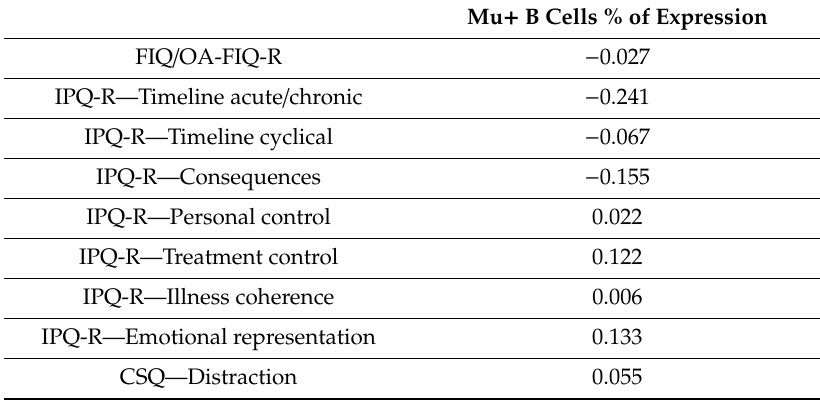
Table 3. Mu + B cells percentage of expression had no significant correlations with any psychological aspects investigated. Pearson’s correlations between Mu + B cells percentage of expression and total FIQ score, IPQ-R subscales, CSQ subscales, the total CPAQ score and DASS) subscales. Mu + B Cells % of Expression FIQ /